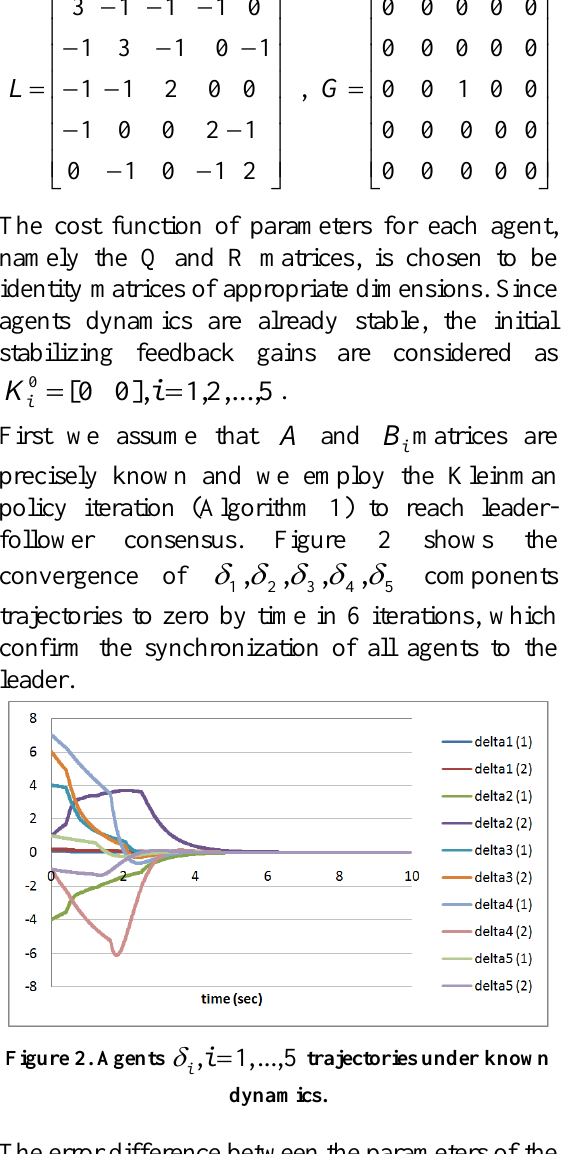
Figure 4. Convergence of k